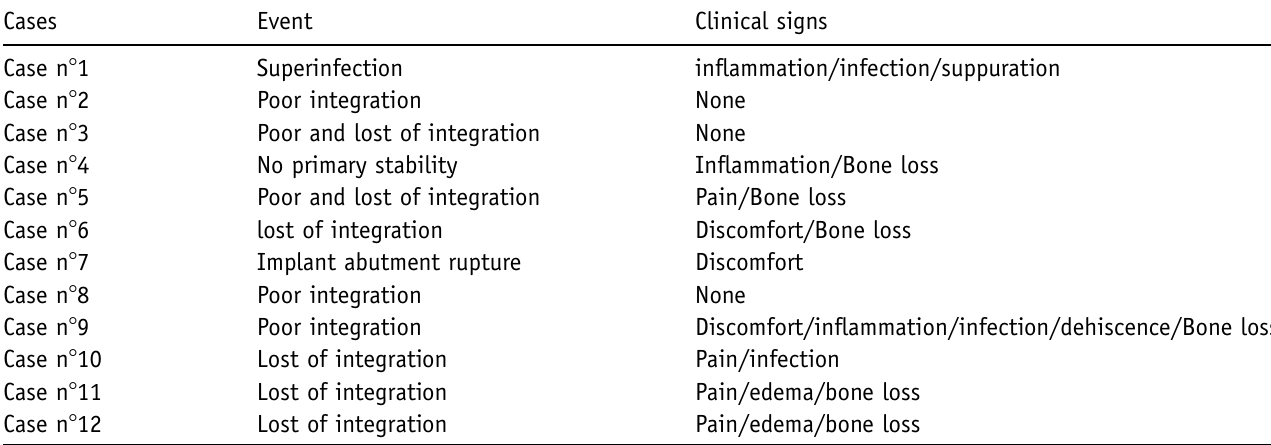
Table III. Clinical signs and types of event associated with